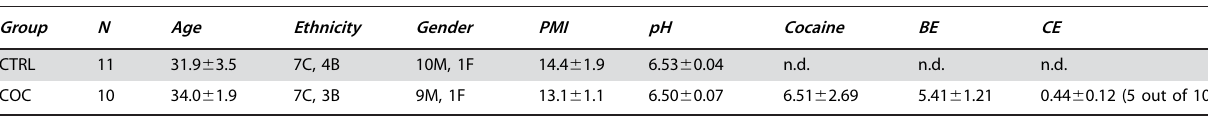
Table 1. Demographics, postmortem interval (PMI), brain pH and toxicology .. ... .... ... ... .... ... ... .... ... ... .... ... ... .... ... ... .... ... ... .... ... ... .... ... ... .... ... ... .... ... ... .... ... ... .... ... ... .... ... ... .... ... ... . Group